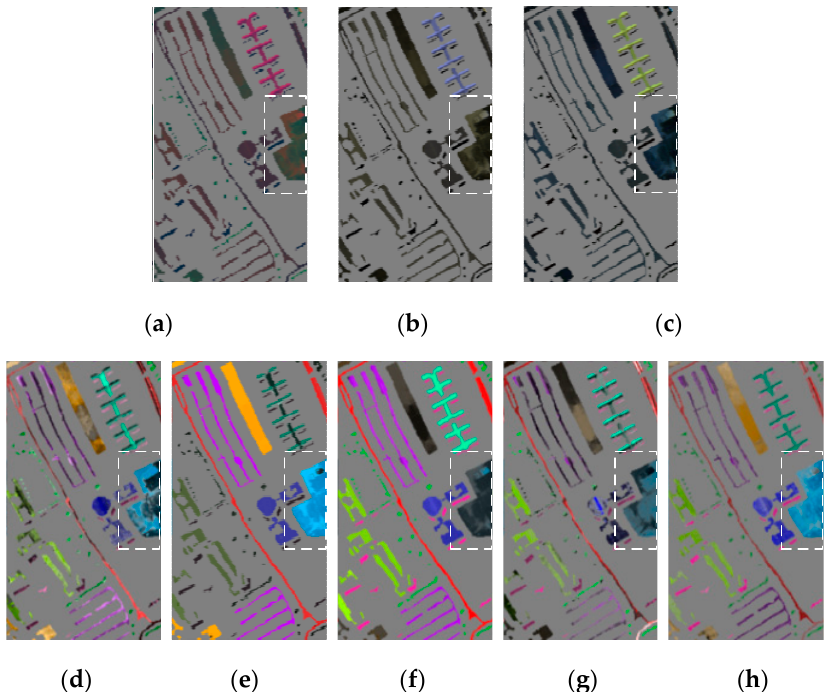
Figure 6. Visualization result for Pavia University. ( a ) PCA; ( b ) CMF; ( c ) band selection; ( d ) T-SNE; ( e ) LTSA; ( f ) LLE; ( g ) LE; ( h ) ISOMAP.